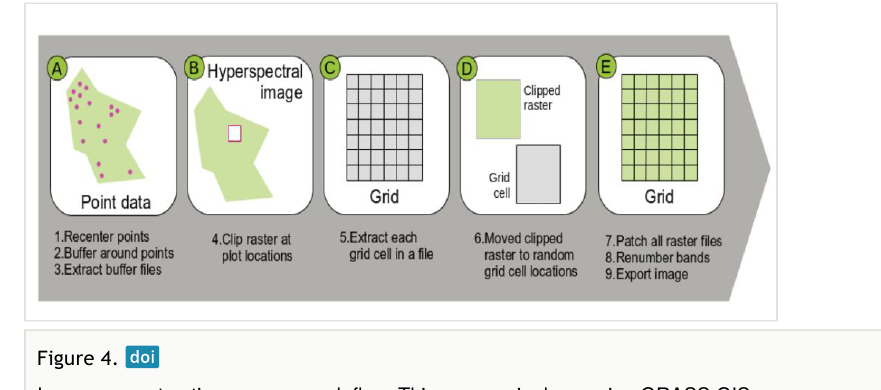
Figure 4. Image reconstruction process work fl ow. This process is done using GRASS GIS.